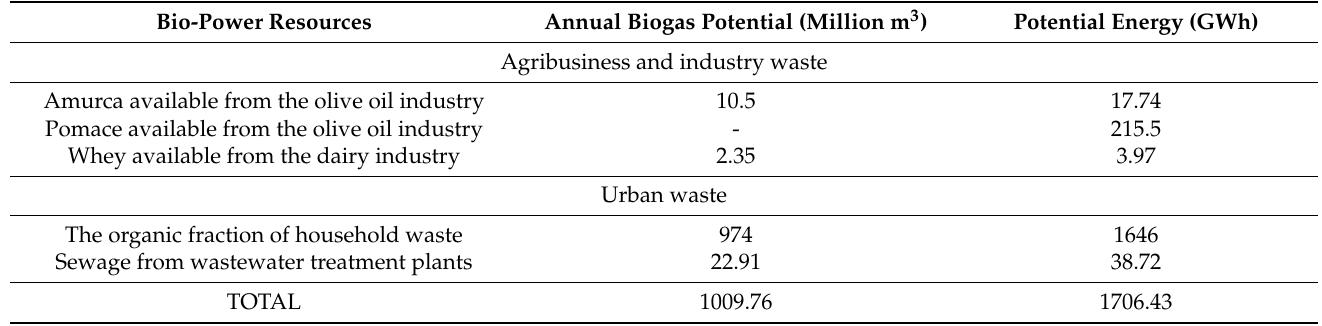
Table 3. Potential bio-power in Algeria.